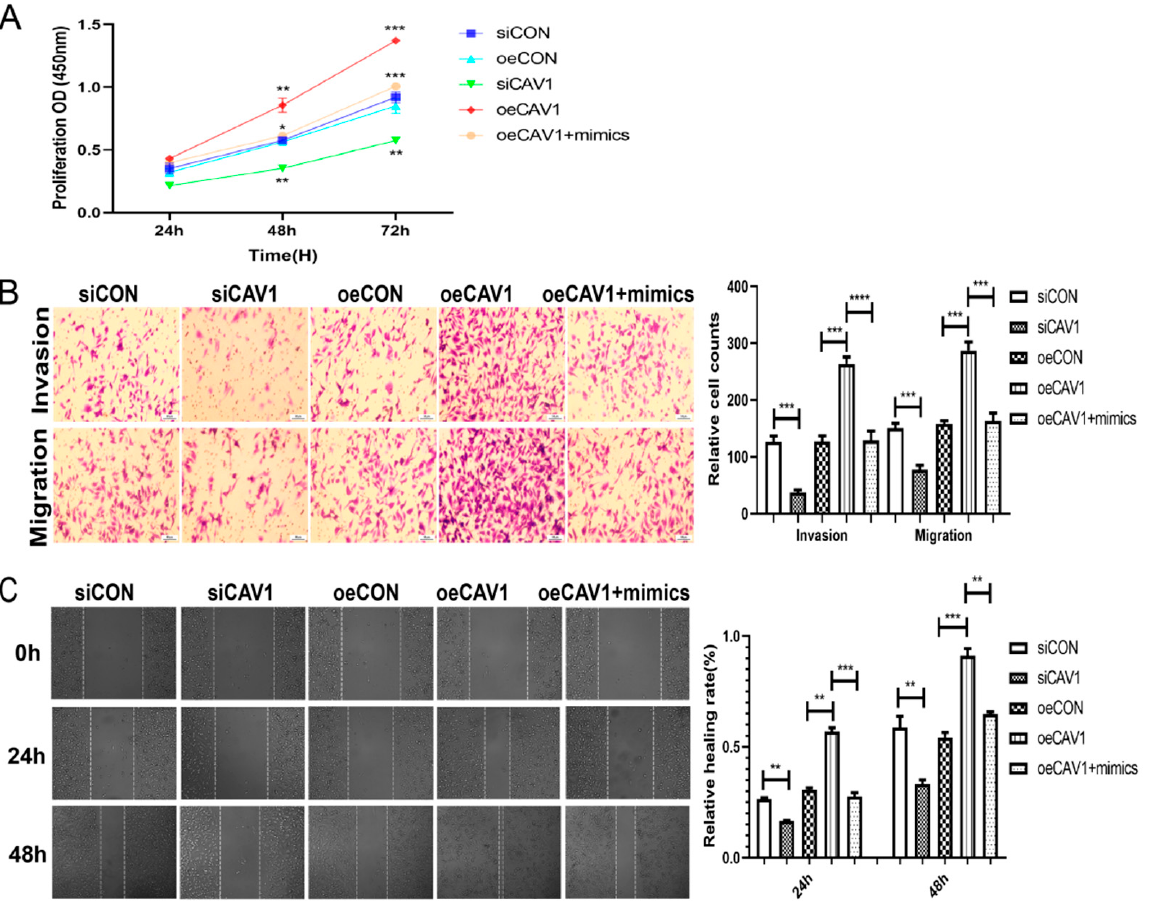
Figure 6. miR-203 inhibits the effect of CAV1 on MDA-MB-231 cells in proliferation, invasion, and migration. ( A ) CCK-8 results showed that the down-regulation of CAV1 significantly reduced the cell proliferation rate after 48 h and 72 h. Compared with the oe CAV1 group, the proliferation rate of the cells in the co-transfected m iR-203 (oe CAV1 + mimics) group decreased. ( B ) The transwell invasion and migration assay results showed that the number of MDA-MB-231 cells invading and migrating in the oe CAV1 group increased. The number of cell invasions and migrations in the oe CAV1 + mimics group was lower than that in the oe CAV1 group. ( C ) The wound healing assay showed that the migration area of cells in the oe CAV1 group increased. The migration area of cells in the oe CAV1 + mimics group was smaller than that in the oe CAV1 group. Values were significantly different compared with the corresponding control value at * p < 0.05, ** p < 0.01, *** p < 0.001, **** p <